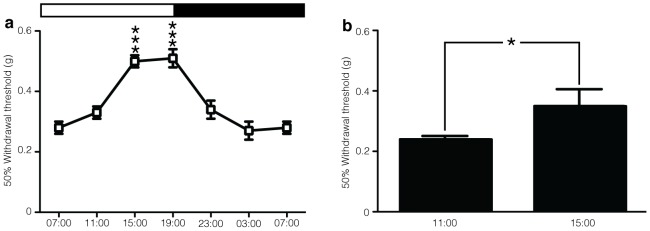
The affect of circadian rhythm on von Frey responses over a 24-hour period.(a) Behavioural responses of C57BL/6 mice to the von Frey hairs applied to the hindpaw over a 24 h period. Measurements were taken every 4 hours starting at 07:00. (b) Behavioural responses of Nav1.8-DTA mice to the von Frey hairs applied to the hindpaw over a 24 h period. (a) Data analysed by two-way analysis of variance followed by a Bonferroni post-hoc test and (b) t-test. Results are presented as mean ± S.E.M. * P<0.05, *** P<0.001.